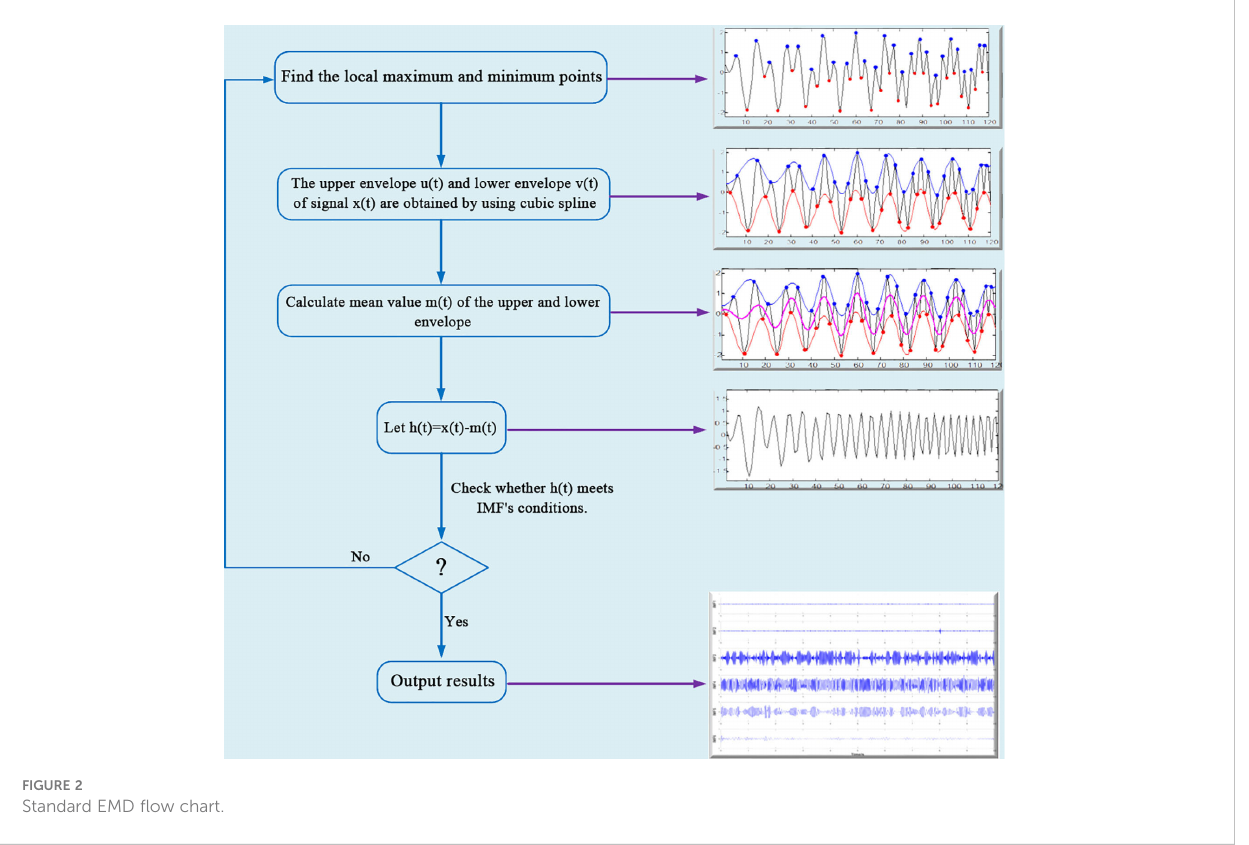
FIGURE 2 Standard EMD fl ow